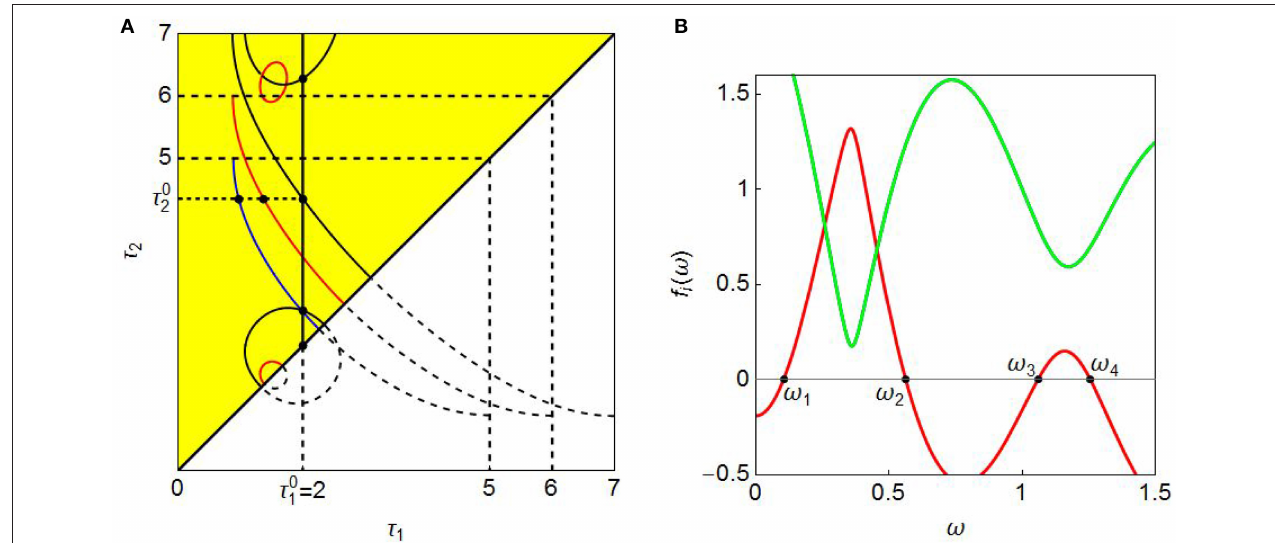
FIGURE 6 | τ 3 -effects on switching curves: (A) Stability switching curves; (B) Triangle conditions.